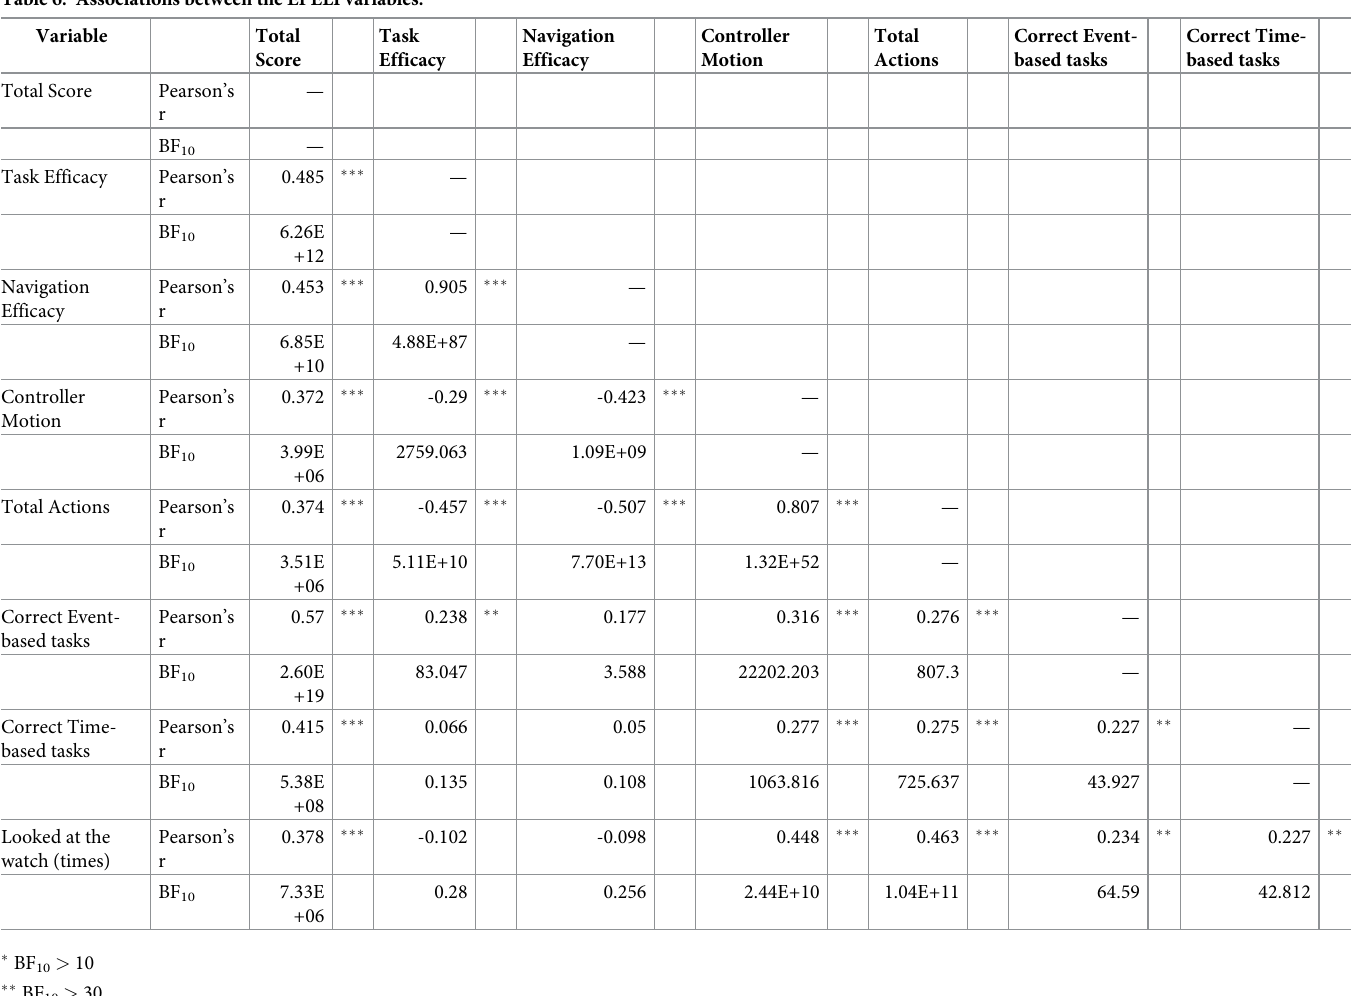
Table 6. Associations between the EPELI